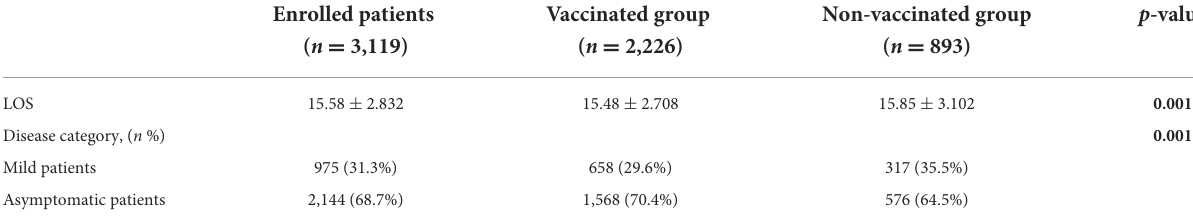
TABLE 2 In-hospital stays and outcome differences between the two groups ( n =